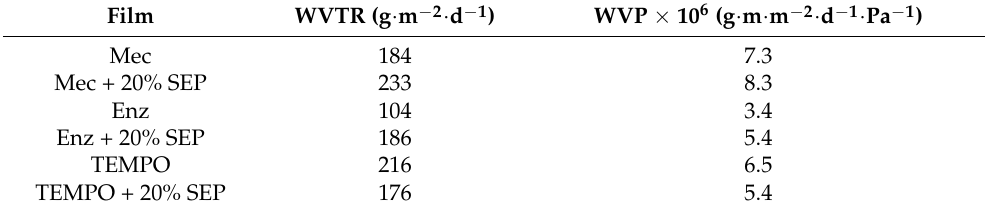
Table 3. Barrier properties of the films obtained by filtration + hot